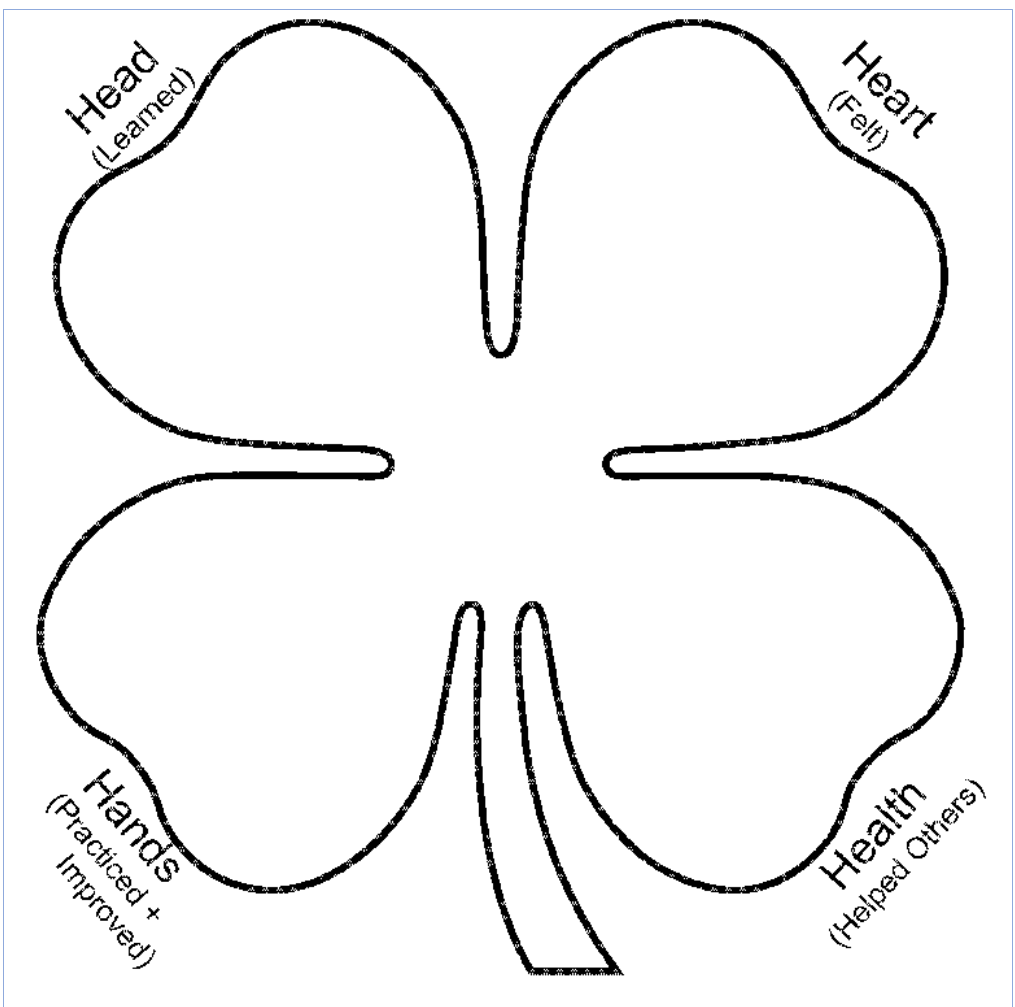
Figure A1. Youth Clover Reflection Sheet (Adapted from Arnold & Gifford,